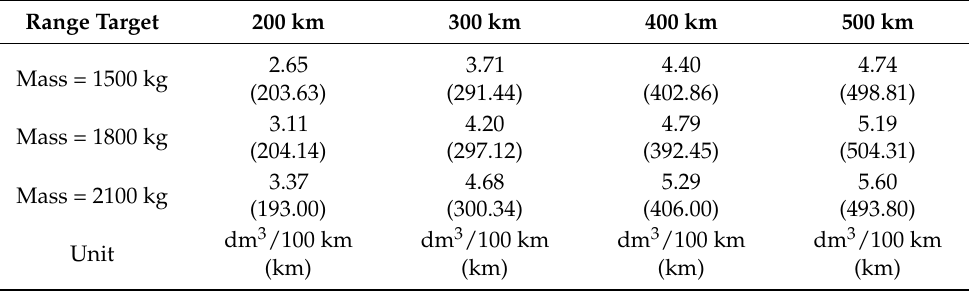
Table A10. Fuel consumption in EREV mode for constant speed drive at 110